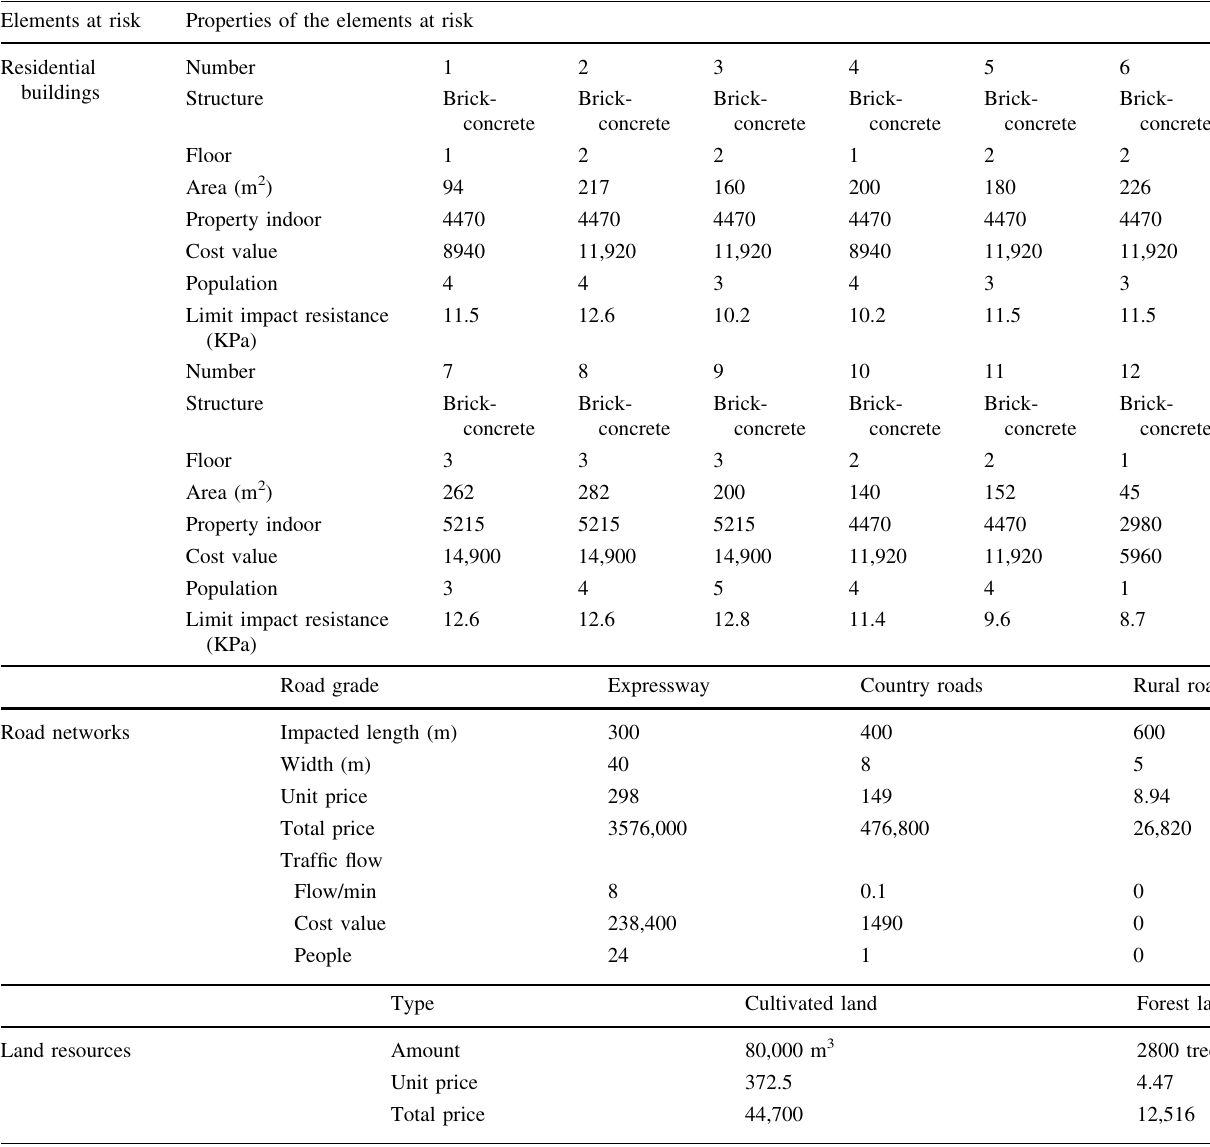
Table 3 Statistical data of the elements at risk derived from field surveys (unit of value: USD) in the 2013 Sunjia landslide study area in Wanzhou County Elements at